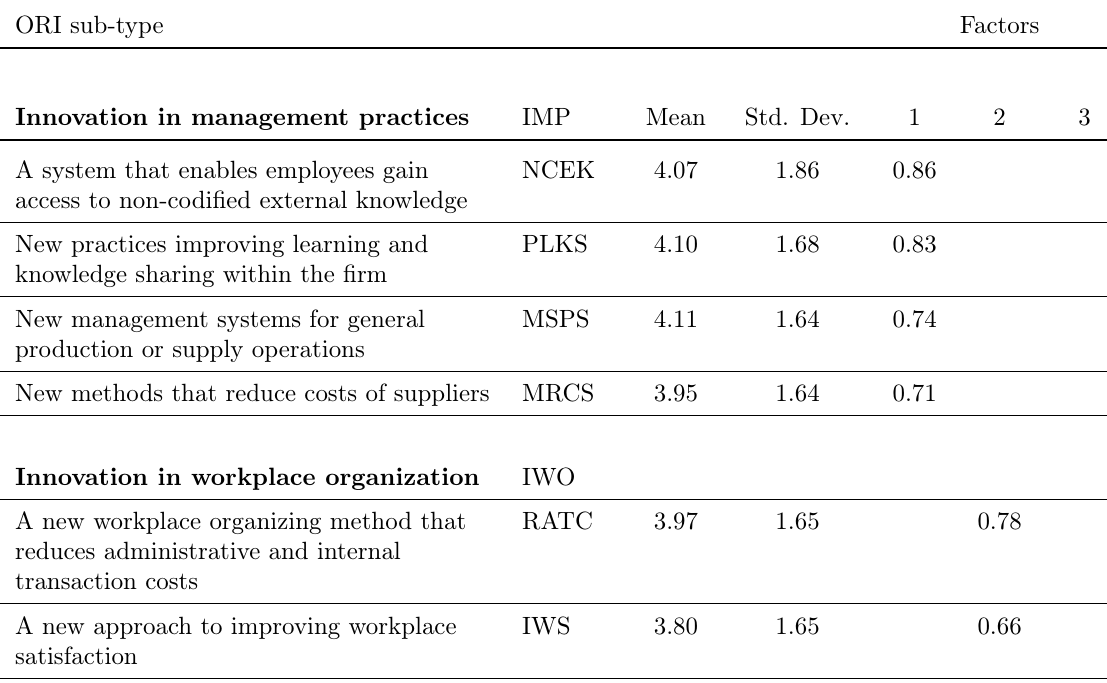
Table 1. Organizational Innovation. Results of the factor analysis applied to OI variables.